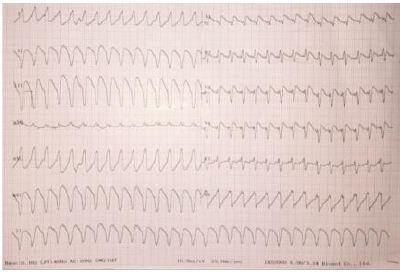
Figure 1 . P atient’s ECG showed ventricular tachycardia